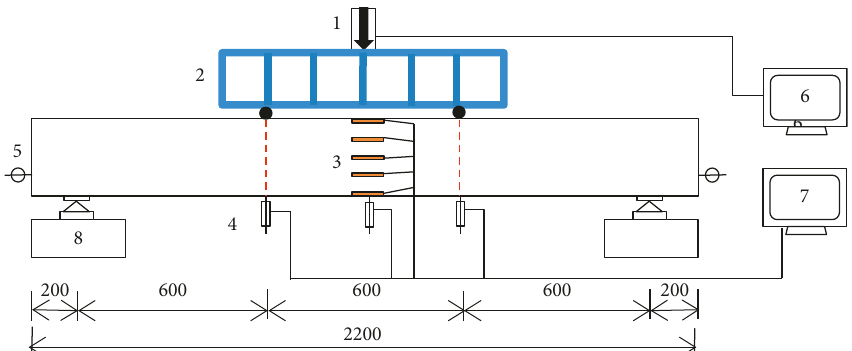
Figure 5: Loading test setup (unit: mm). Note:1, load cell; 2, steel spreader beam; 3, strain gauge; 4, displacement sensor; 5, dial indicator; 6, computer; 7, data acquisition